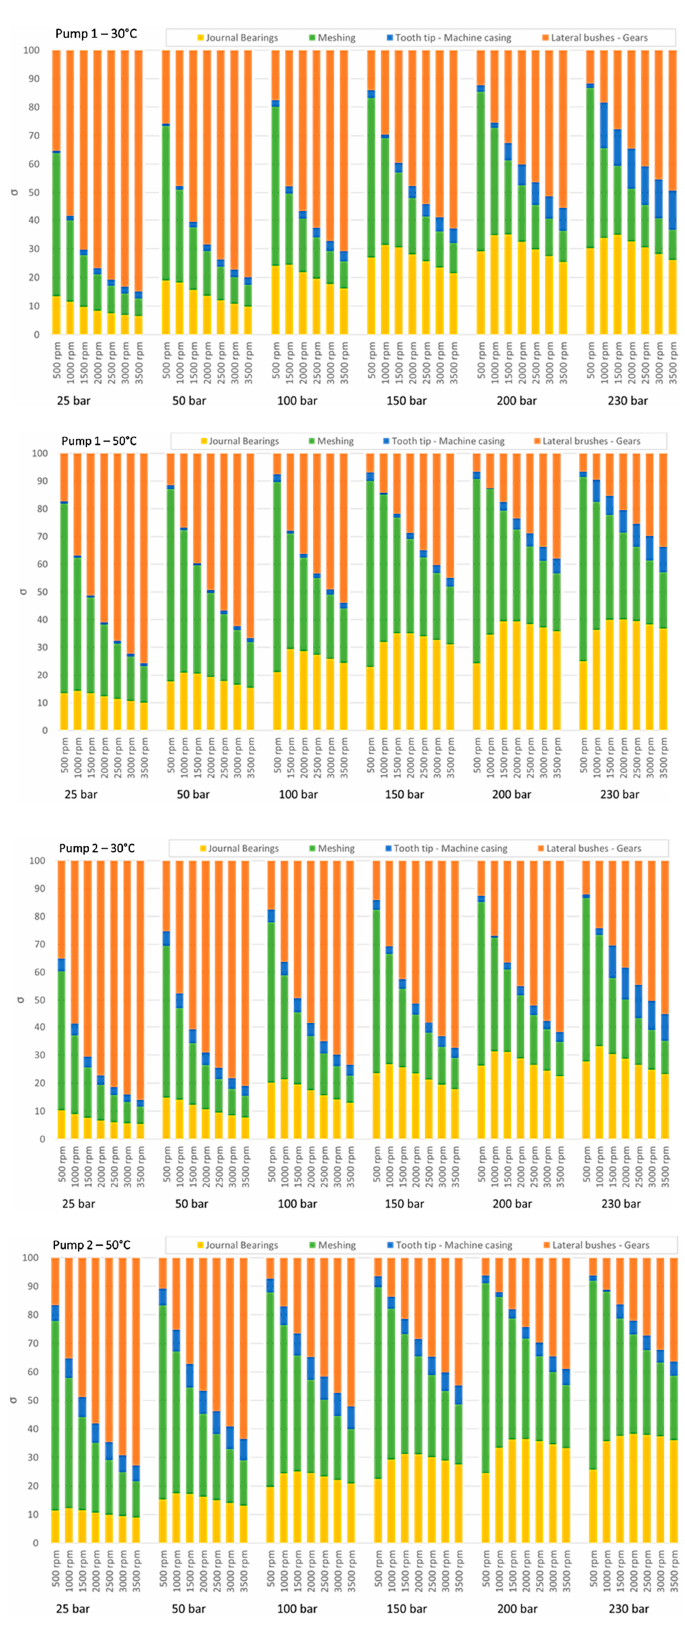
Figure 12. Losses weight in percentage ( σ ) for pump 1 and 2 at 30 °C and 50 °C fluid temperature and for all the operating conditions tested.